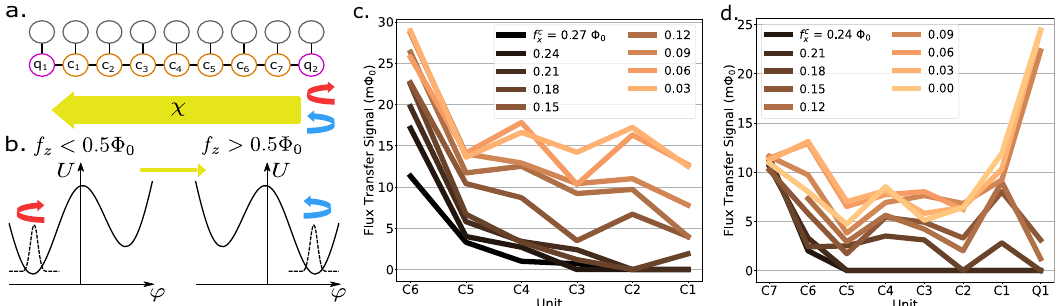
Fig. 3 The Flux Propagation Experiment. a A schematic depicting the fl ux propagation experiment. Either Coupler 7 [results in c ], or Qubit 2 [results in d ], act as the source unit generating the fl ux signal. The fl ux response is then measured in the different units along the chain. b The fl ux bias point causing that unit's circulating current fl ux signal is generated by sweeping the f z of the source unit across its one-half magnetic to change direction. c , d The magnitude of the experimentally measured fl ux signal is displayed for different homogeneously tuned coupler f x values for the coupler-only c and full device d . The displayed signal is the difference in effective f z = Φ 0 /2 point when the source unit is placed at f z = Φ 0 /2 ± 20 m Φ 0 . Based on full device simulations, this range fully captures the transition of the target unit's fl ux response (see Supplementary Fig. 8f). This prediction is further validated by measurements extending to larger f z offsets of the source unit. As the strong coupling between the tunable resonator and the qubit (coupler) makes it challenging to model the resonator response, we therefore resort to image processing techniques to determine the effective symmetry point of the qubit (coupler) unit. This sets the uncertainty of the extracted fl ux signal to be on the order of the pixel size of the scan, 2.4 m Φ 0 . In the case of both the coupler only and qubit to qubit measurements, the cross chain signal becomes non-zero in the vicinity of the coupler chain's predicted critical